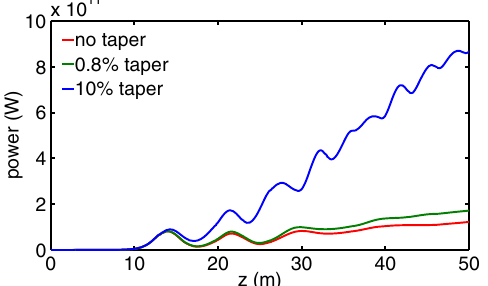
FIG. 3. FEL peak power as a function of z for untapered (red), 0.8%-tapered (green), and 10%-tapered (blue)